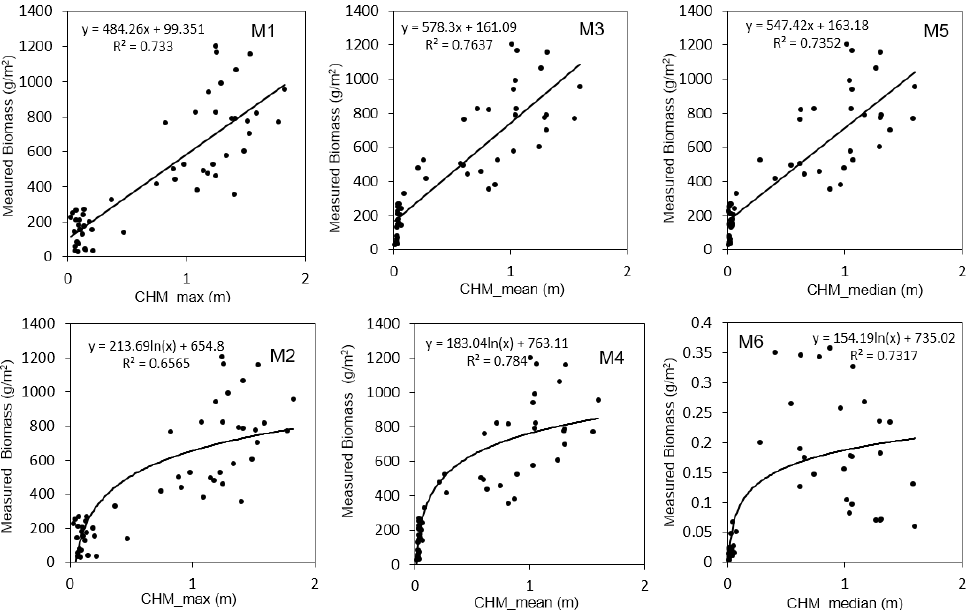
Figure 9. The regression graph results of the six different biomass estimation models. M1: the linear regression constructed by CHM_max; M2: the logarithmic regression constructed by CHM_max; M3: the linear regression constructed by CHM_mean; M4: the logarithmic regression constructed by CHM_mean; M5: the linear regression constructed by CHM_median; M6: the logarithmic regression constructed by